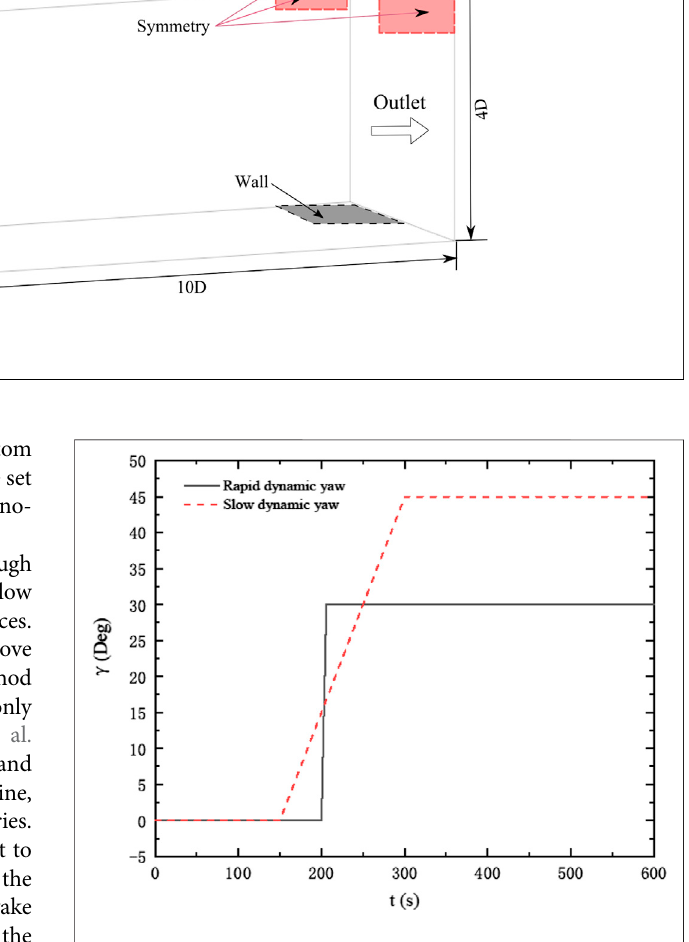
FIGURE 4 | Diagram of the yaw angle with time in the slow and rapid dynamic